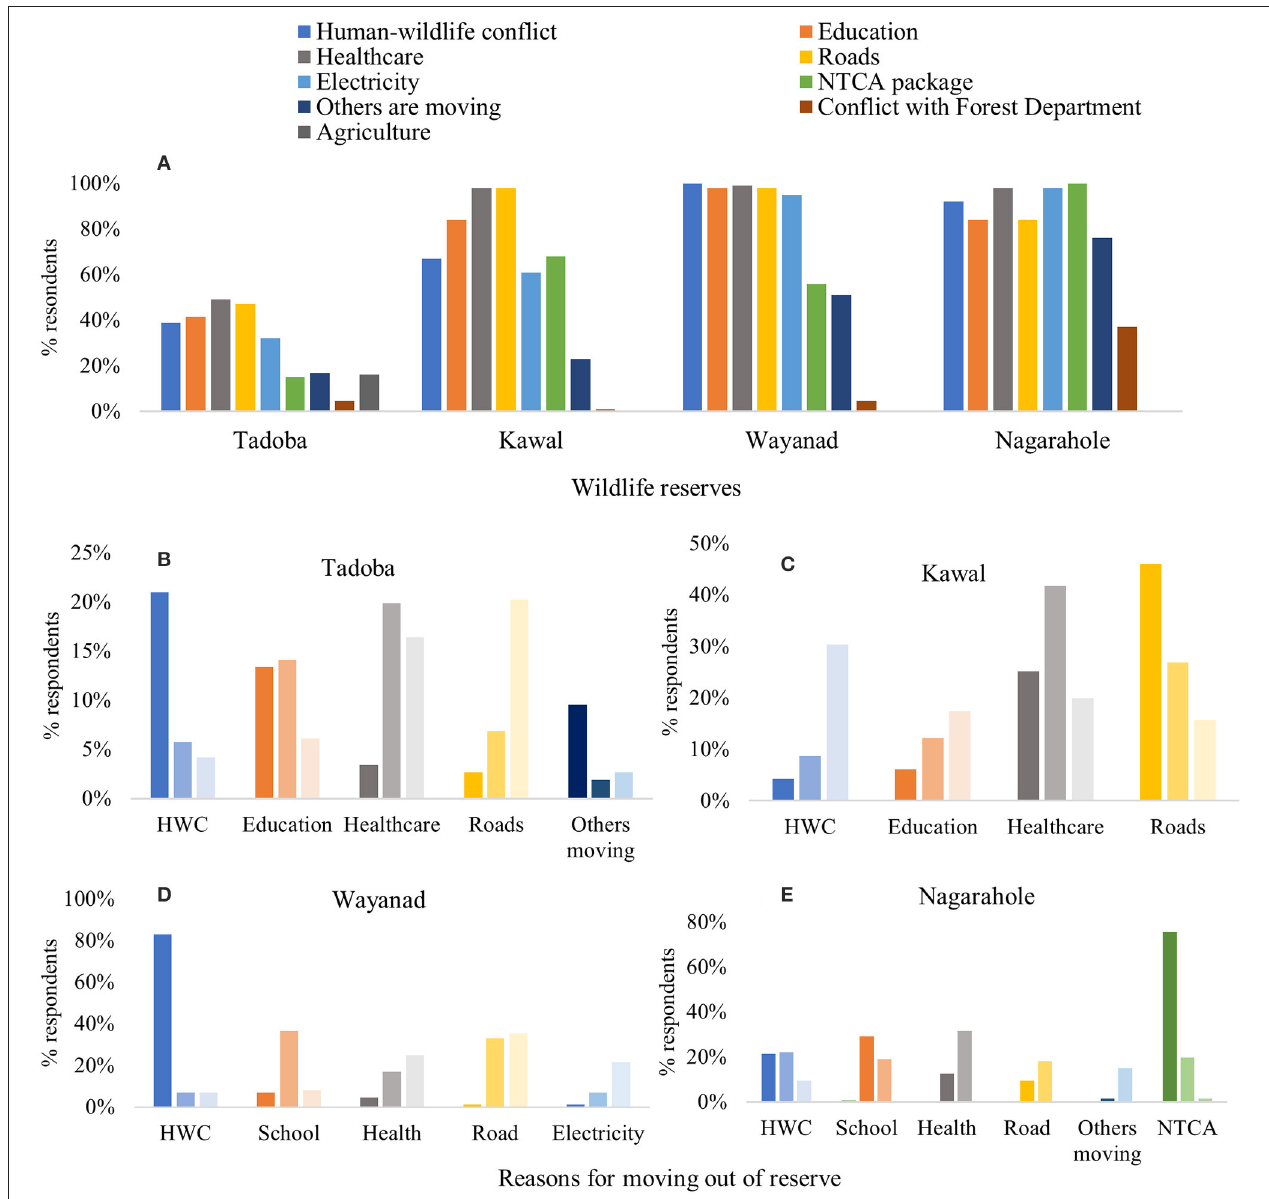
FIGURE 2 | (A) PA-wise reasons listed by respondents to relocate. (B–D) show ranks of most frequently reported reasons ( > 10% respondents) at (B) Tadoba-Andhari Tiger Reserve, (C) Kawal Tiger Reserve, (D) Wayanad Wildlife Sanctuary, and (E) Nagarahole Tiger Reserve. The first bar for each reason